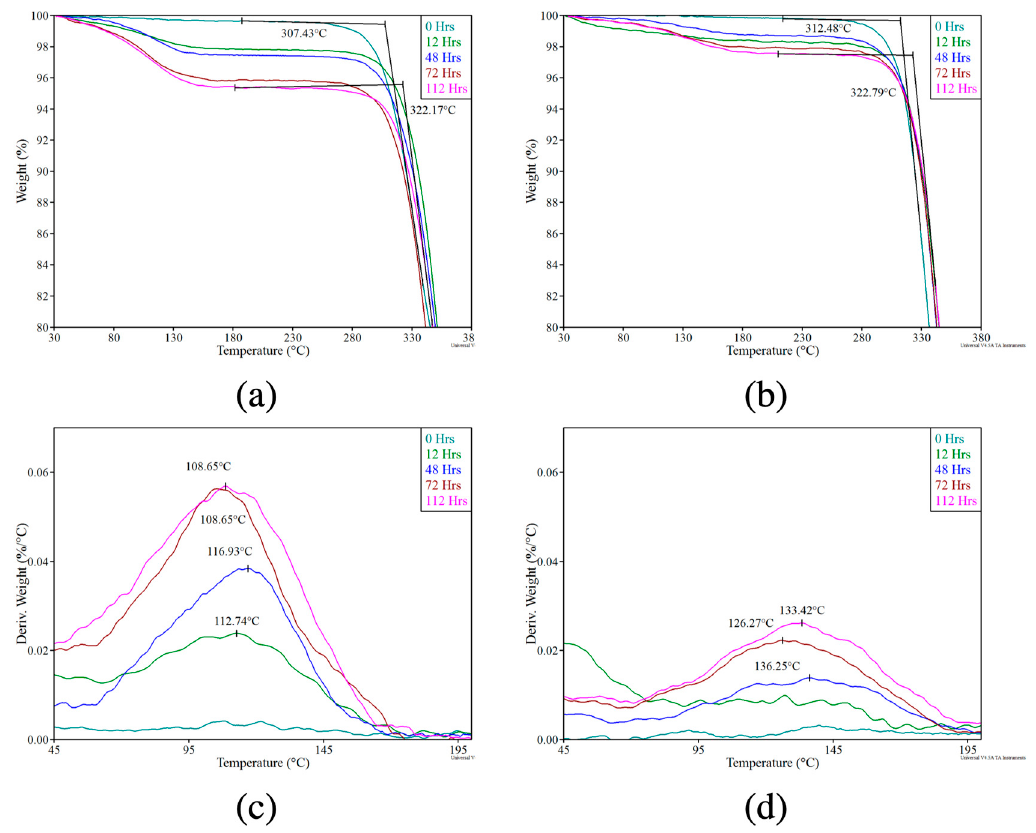
Figure 4. TGA and DTGA curves of ( a ) and ( c ) MM4520; and ( b ) and ( d ) MM7520 after different immersion times in water.